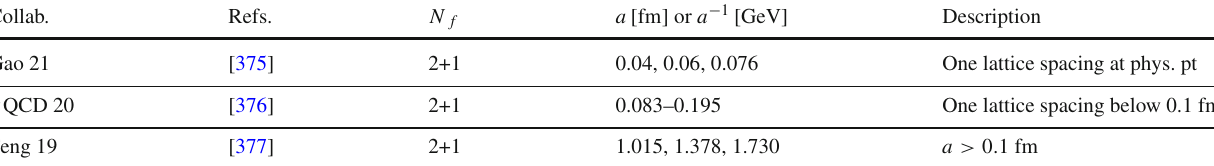
Table 110 Continuum extrapolations/estimation of lattice artifacts in determinations of the low-energy constants related to the vector form factor of the pion Collab.